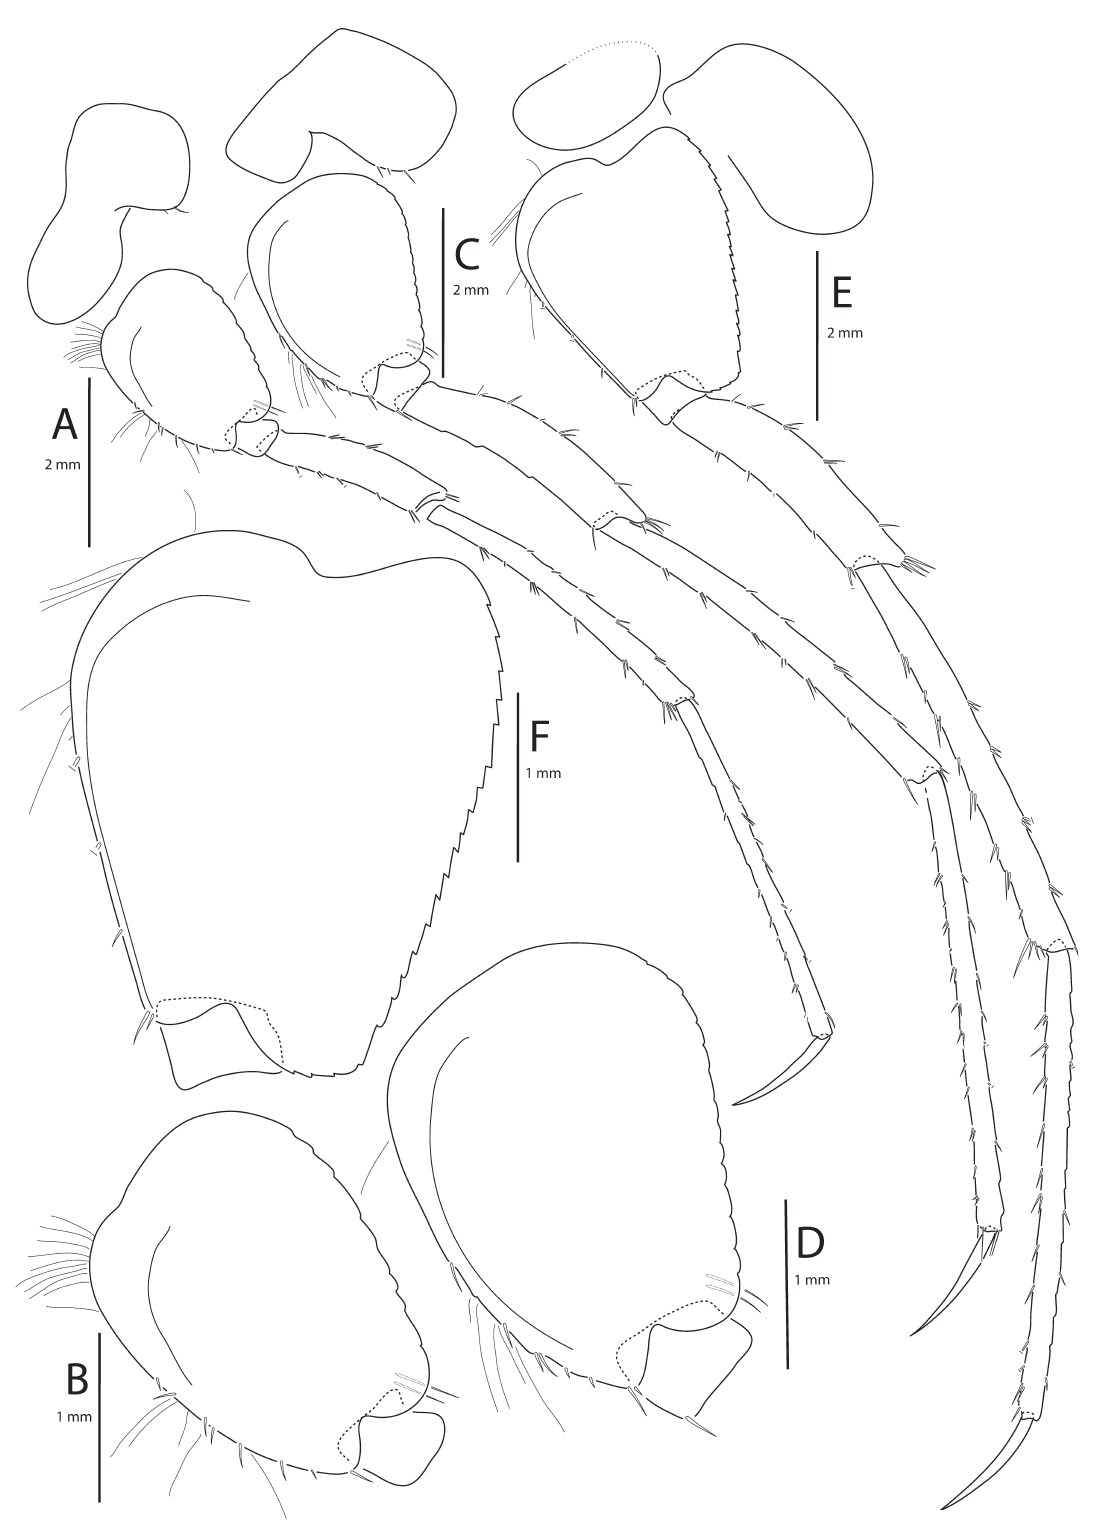
Fig. 6. Halirages cainae sp. nov., holotype ♂, 40 mm, Norwegian Sea, MAREANO 2009-111, R-station 487, sample 157. A . left P5 (basis drawn after right leg). B . basis and ischium of right P5 (inverted). C . left P6 (basis drawn after right leg). D . basis and ischium of right P6 (inverted). E . left P7. F . basis and ischium of left